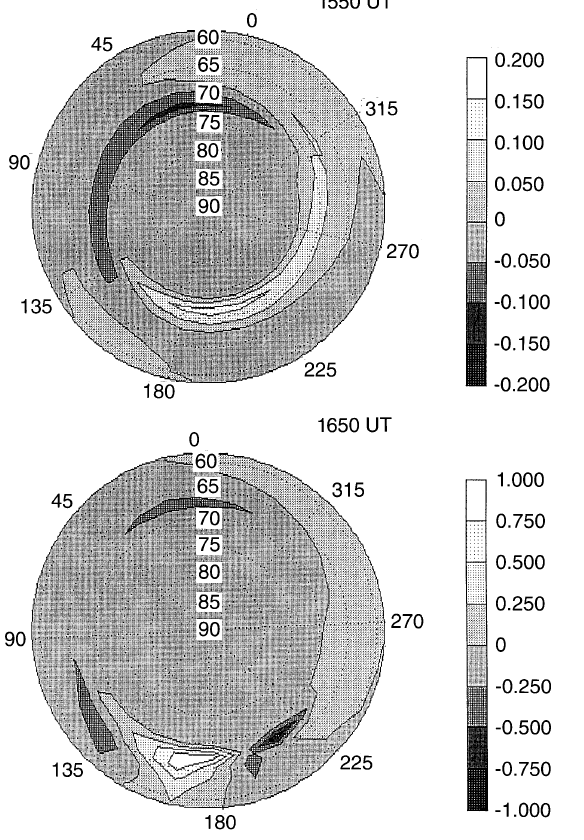
Fig. 5. The calculated variations ( solid curves ) and those observed by EISCAT on 25 March 1987 ( dashed curves ) in the north- ward electric field ( bottom panel ), E-region electron concentration at 111-km altitude and F2-region ion and electron temperature